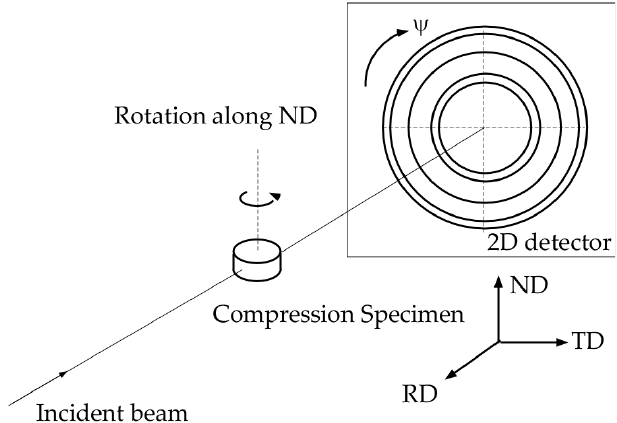
Figure 1. Experimental setup for the texture measurements by high-energy X-ray diffraction on compression-tested twinning-induced plasticity (TWIP) steel specimens.